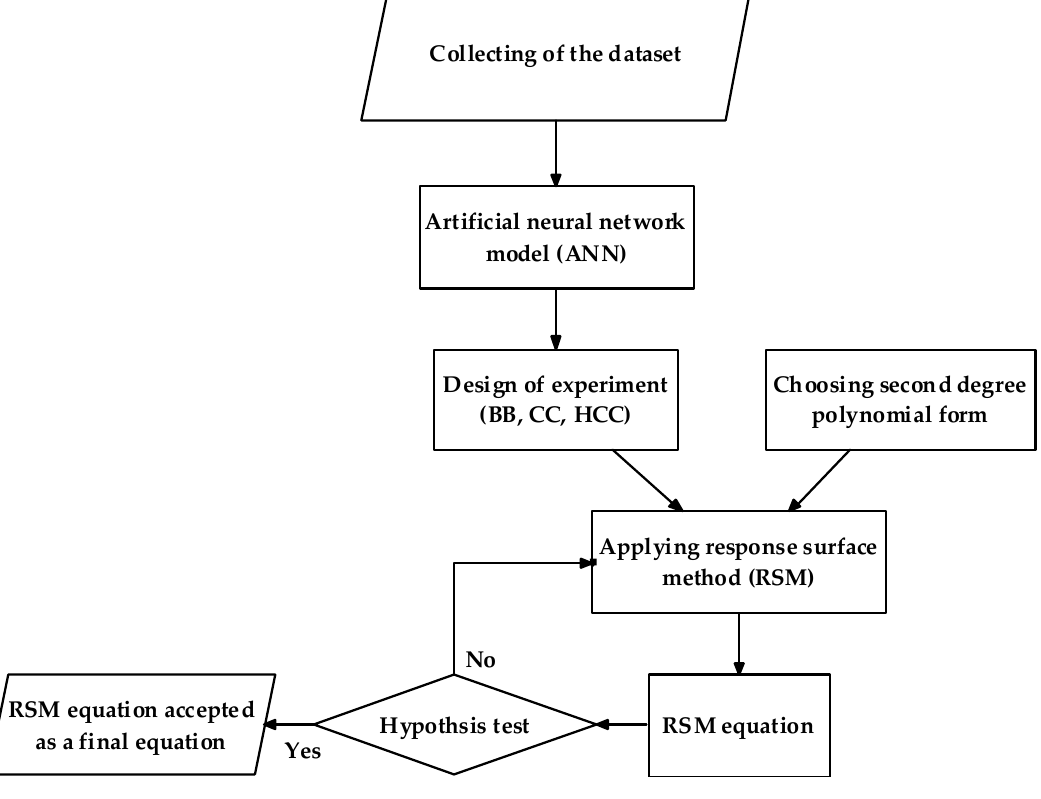
Figure 1. Flowchart of the process to derive the response surface method (RSM) equations in this study; BB: Box-Behnken; CC: central composite ; HCC: half central composite.